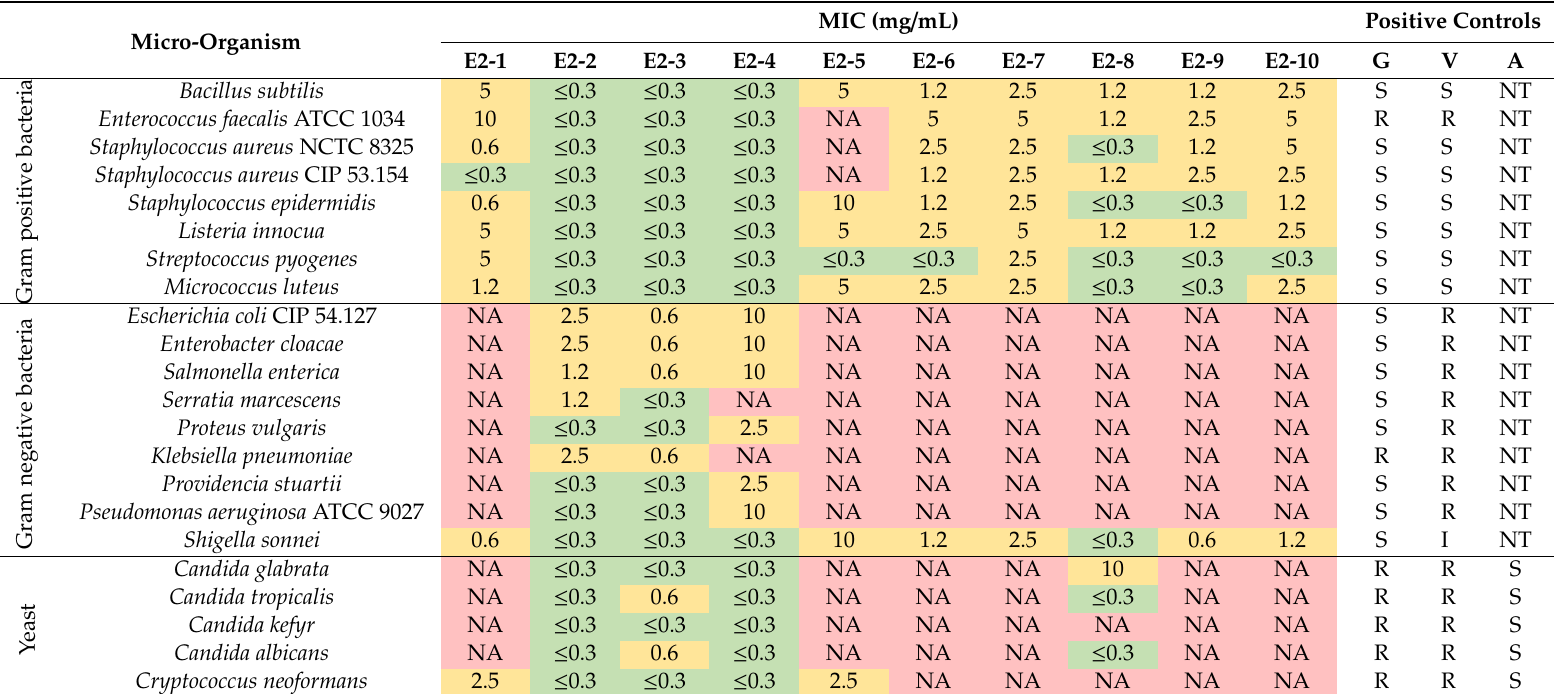
Table 2. Determination on agar plates of the minimum inhibitory concentration (MIC) values of the ten methanol bark extracts against 22 microbial species. Tested concentrations ranged from 0.3 mg / mL to 10 mg /